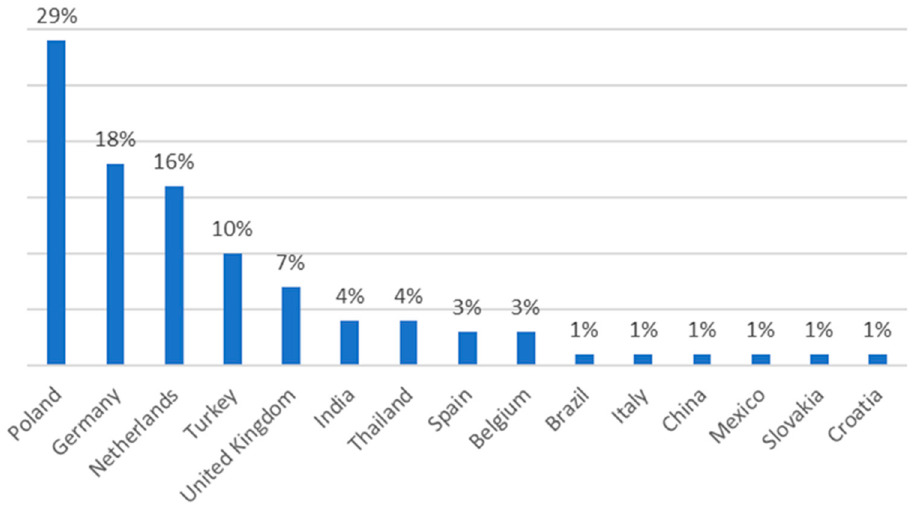
Figure 2. Countries concerned by the notifications of bacterial contamination in the RASFF data- base